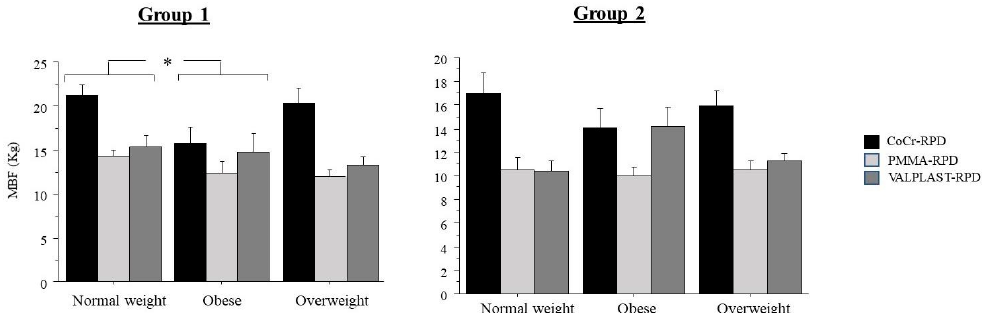
Figure 2. Maximal bite force according to body mass index classification. (MBF = Maximal Bite Force; BMI = Body Mass Index; V-RPD = Valplast Removable Partial Denture; CoCr-RPD = Removable Partial Denture Cobalt-Chromium; PMMA-RPD = Removable Partial Denture in Polymethyl Methacrylate.* = p <0.05) .